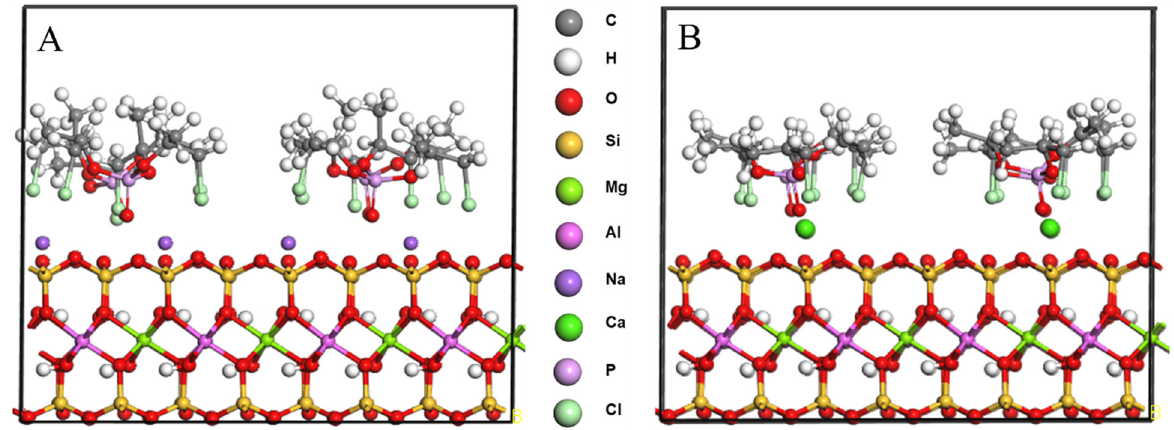
Figure 2. Molecular model after molecular dynamics. ( A ) TCPP/NaMMT; ( B ) TCPP/CaMMT.